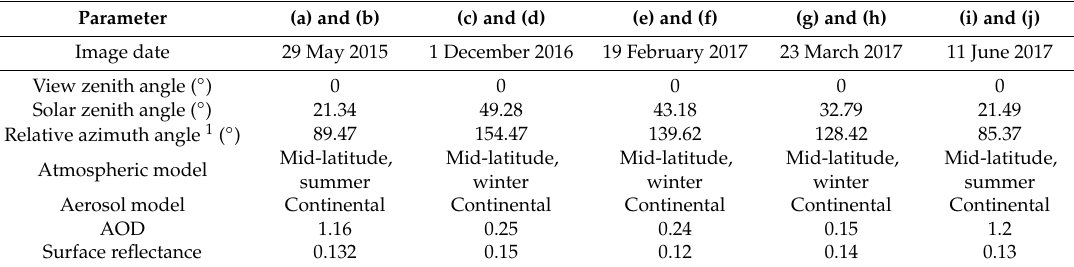
Table 5. The parameters of images in Figure